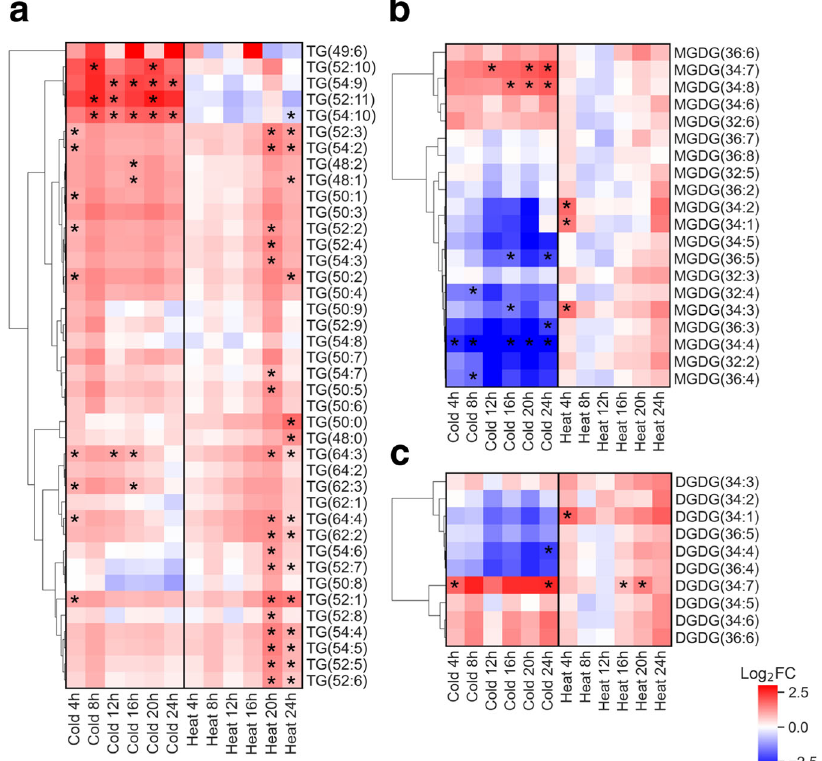
Fig. 5 Fold change of lipid levels in cold stress and heat stress samples. Heatmaps show fold change over time in a triacylglycerol (TG) levels, b monogalactosyldiacylglycerol (MGDG) levels, and c digalactosyldiacylglycerol (DGDG) levels of the highest abundance species in cold stress and heat stress samples relative to the control samples at the corresponding time point. Labels for molecular species indicate the number of carbons in the fatty acyl chains followed by the number of double bonds. Asterisks (*) indicates p -value < 0.05. Rows are ordered by hierarchical clustering of mean fold change over three time points of the heat stress samples, there were several (34:2, 34:3, 34:4, 34:5), decreased in the cold stress. Similarly, for polyunsaturated TAGs (52:10, 52:11, and 54:10) that were higher DGDG species, DGDG (34:7) levels increased in cold stress and only in the cold stress samples. Of the high abundance MGDG DGDG (34:4) decreased in the cold stress. In general, the lipids species, MGDG (34:7) levels increased in the cold stress, whereas with a higher degree of desaturation increased in abundance in levels of those MGDG species with fewer double bonds, MGDG the cold stress samples relative to the control.